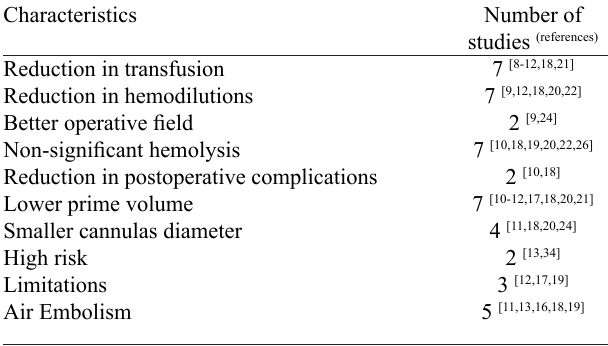
Table 1. Overview of randomized studies that examined the use of vacuum assisted